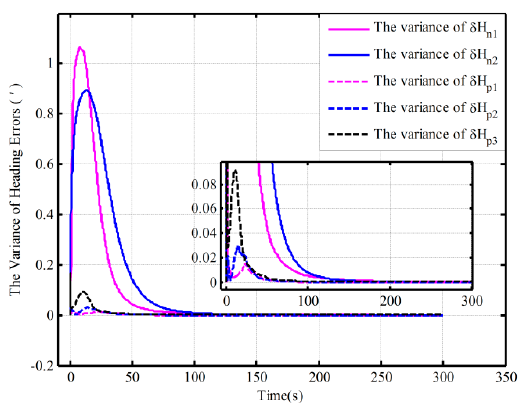
Figure 8. The error variance curves of heading based on the closed-loop KF.